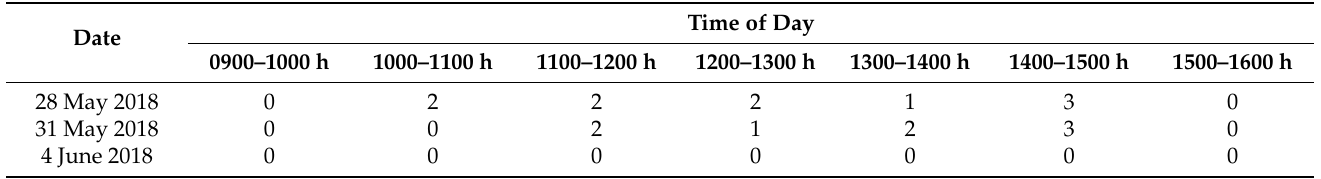
Table 3. Visitation frequency of the effective pollinator Lasioglossum virideglaucum to four flowering shoots of Cypripedium guttatum